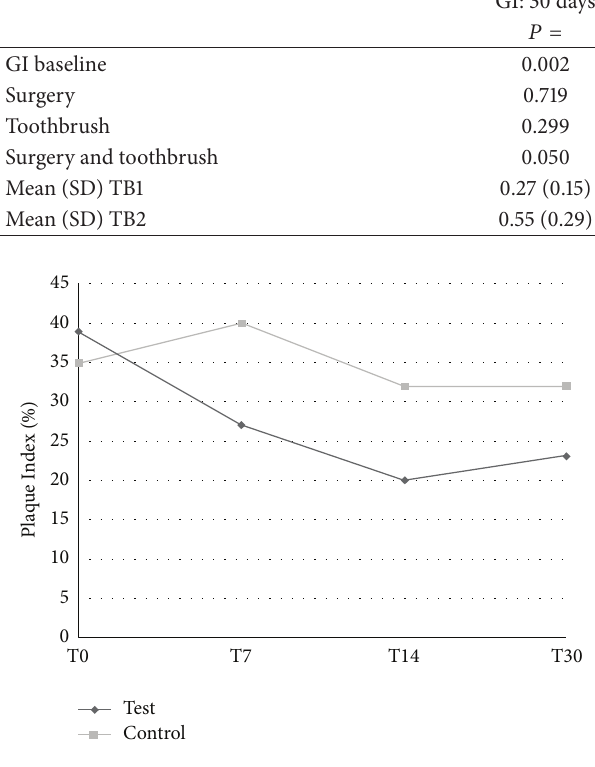
Figure 3: Plaque Index at each time point of the study for test (TB1) and control (TB2) toothbrushes.